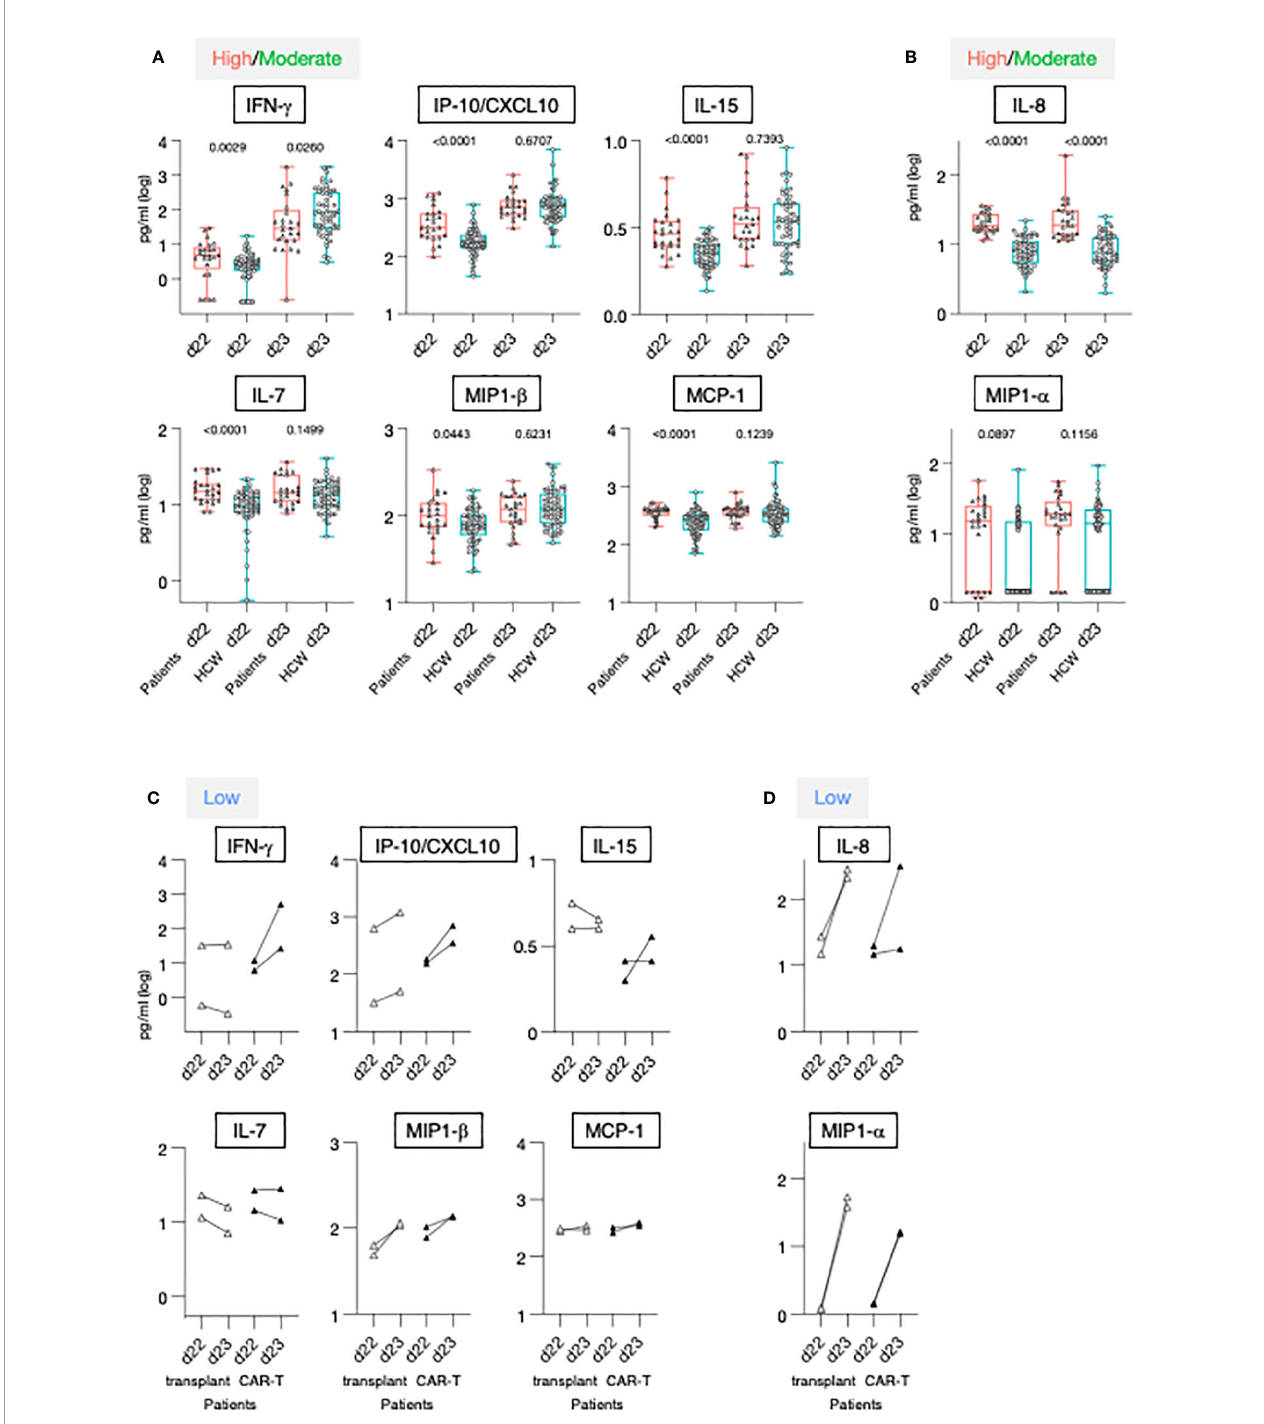
FIGURE 5 | Serum cytokine levels after the 1 st and 2 nd vaccination in patients and HCW. (A, B) Cytokine and chemokine levels were measured over time using the MSD assay on the day of (d22) and at 24 hrs (d23) after 2 nd vaccination in 25 patients with moderate-to-high vaccine-induced Ab titer (red triangles) and 57 HCW [blue circles, as reported (21)]. Whisker plots show overtime log10 serum levels of the high/moderate group (A) IFN- g , IP-10/CXCL10, IL-15, IL-7, MIP-1 b , MCP-1 and (B) IL-8 and MIP-1 a . Differences at each timepoint between these groups were analyzed using Mann-Whitney tests. (C, D) Cytokine levels detected in the 4 low responder patients, with Ab levels at or below threshold, are also plotted overtime, after the 2 nd vaccination (patients on medication lacking B cells, open triangles; patients received CAR-T cell therapy, fi lled